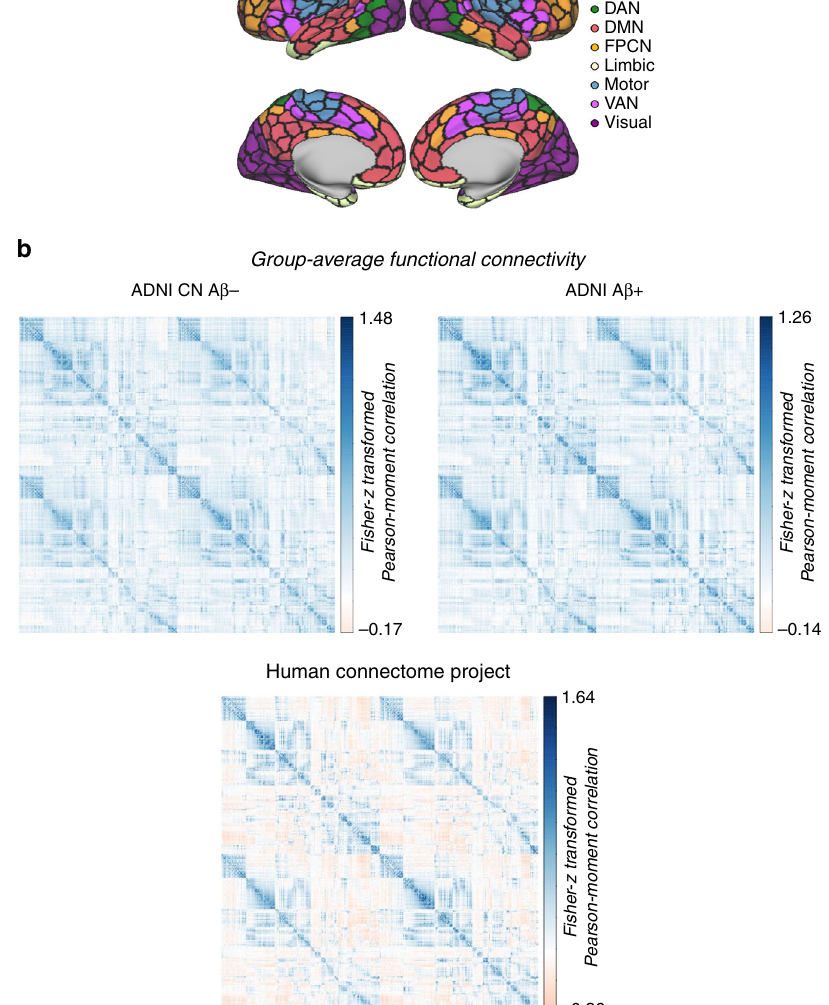
Fig. 2 Brain parcellation and resting-state fMRI. a Surface rendering of the 400 ROI brain parcellation that was applied to tau-PET and resting-state fMRI data for ROI based analyses. b Group-average functional connectivity matrices for 28 CN A β − and 53 A β + of the ADNI sample, as well as for 500 subjects from the human-connectome project (HCP). In ADNI, no Bonferroni-corrected differences ( p < 0.05) in functional connectivity were found between the A β + and CN-A β − in ANCOVAS controlling for age, sex, education and